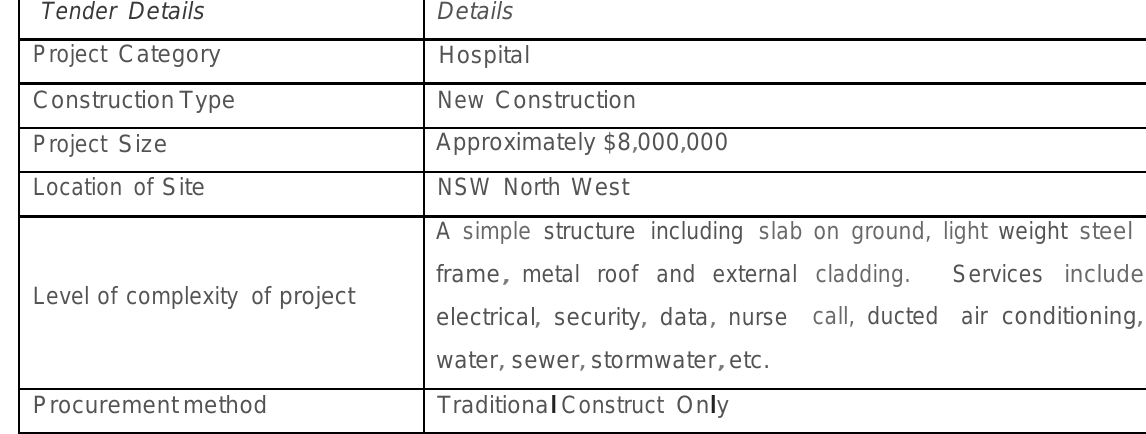
Table 3: Details of test tender